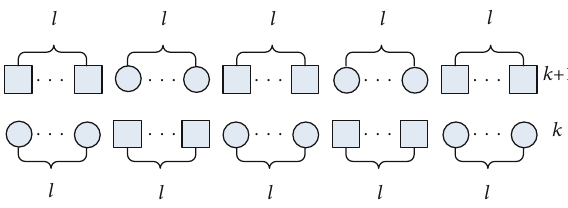
Figure 1: Computational lattice diagram of PASE-I